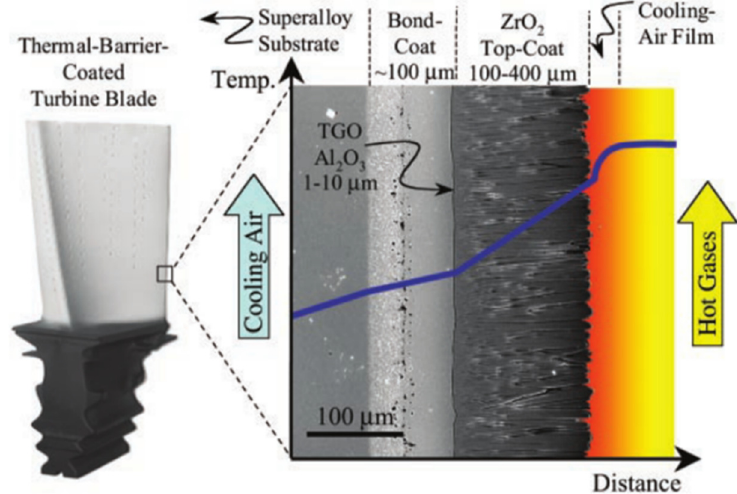
Figure 10. Scanning electron microscope (SEM) images of thermal barrier coating (TBC) (reproduced with permission from [58], The American Association for the Advancement of Science, 2002).